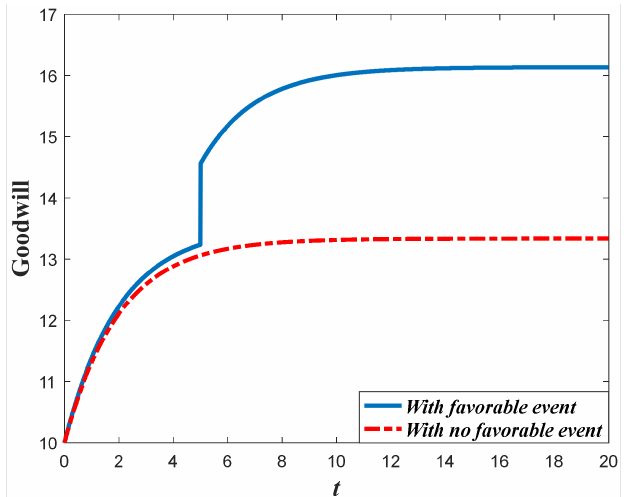
Figure 15. Goodwill level before and after the event (Scenario